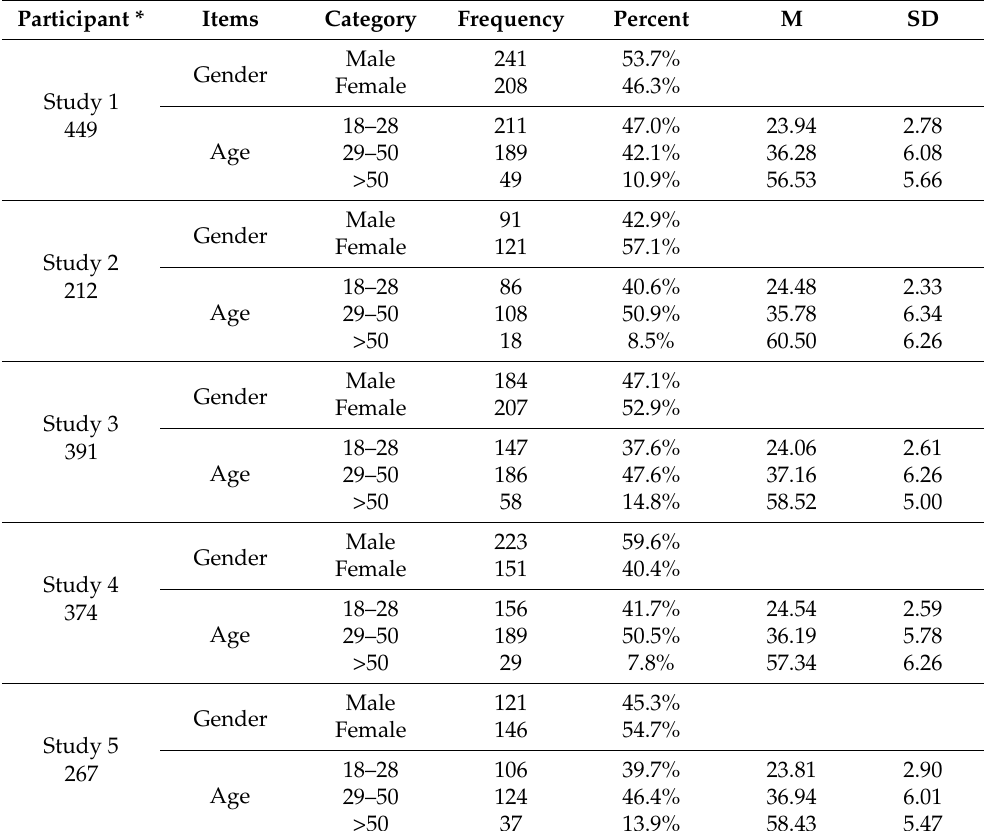
Table 3. Demographical information for the